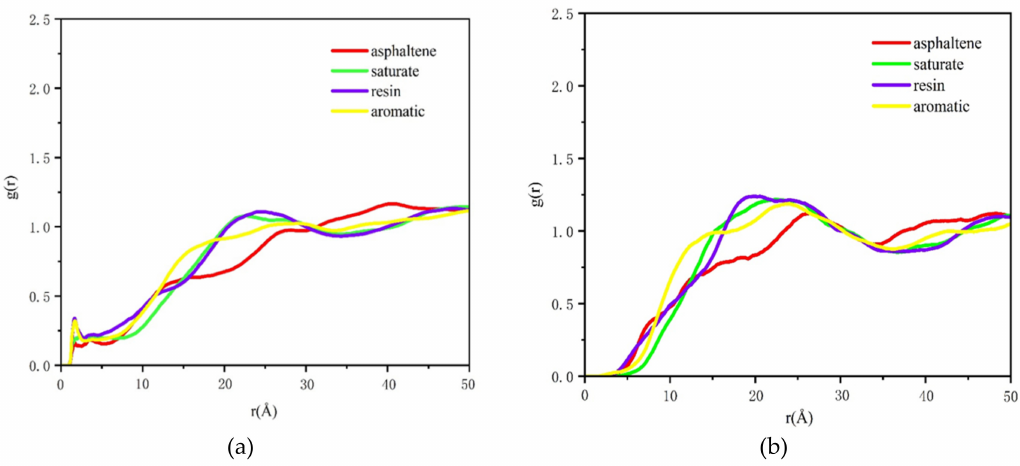
Figure 1. RDF curves of four asphalt components under dry condition. ( a ) Asphalt-calcite ( b ) asphalt-albite.